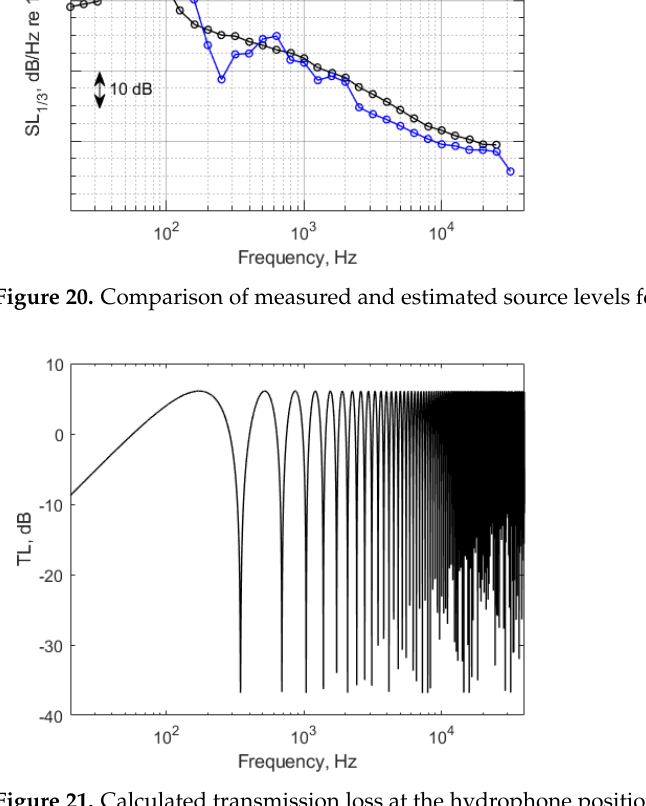
Figure 21. Calculated transmission loss at the hydrophone position (50 m depth).